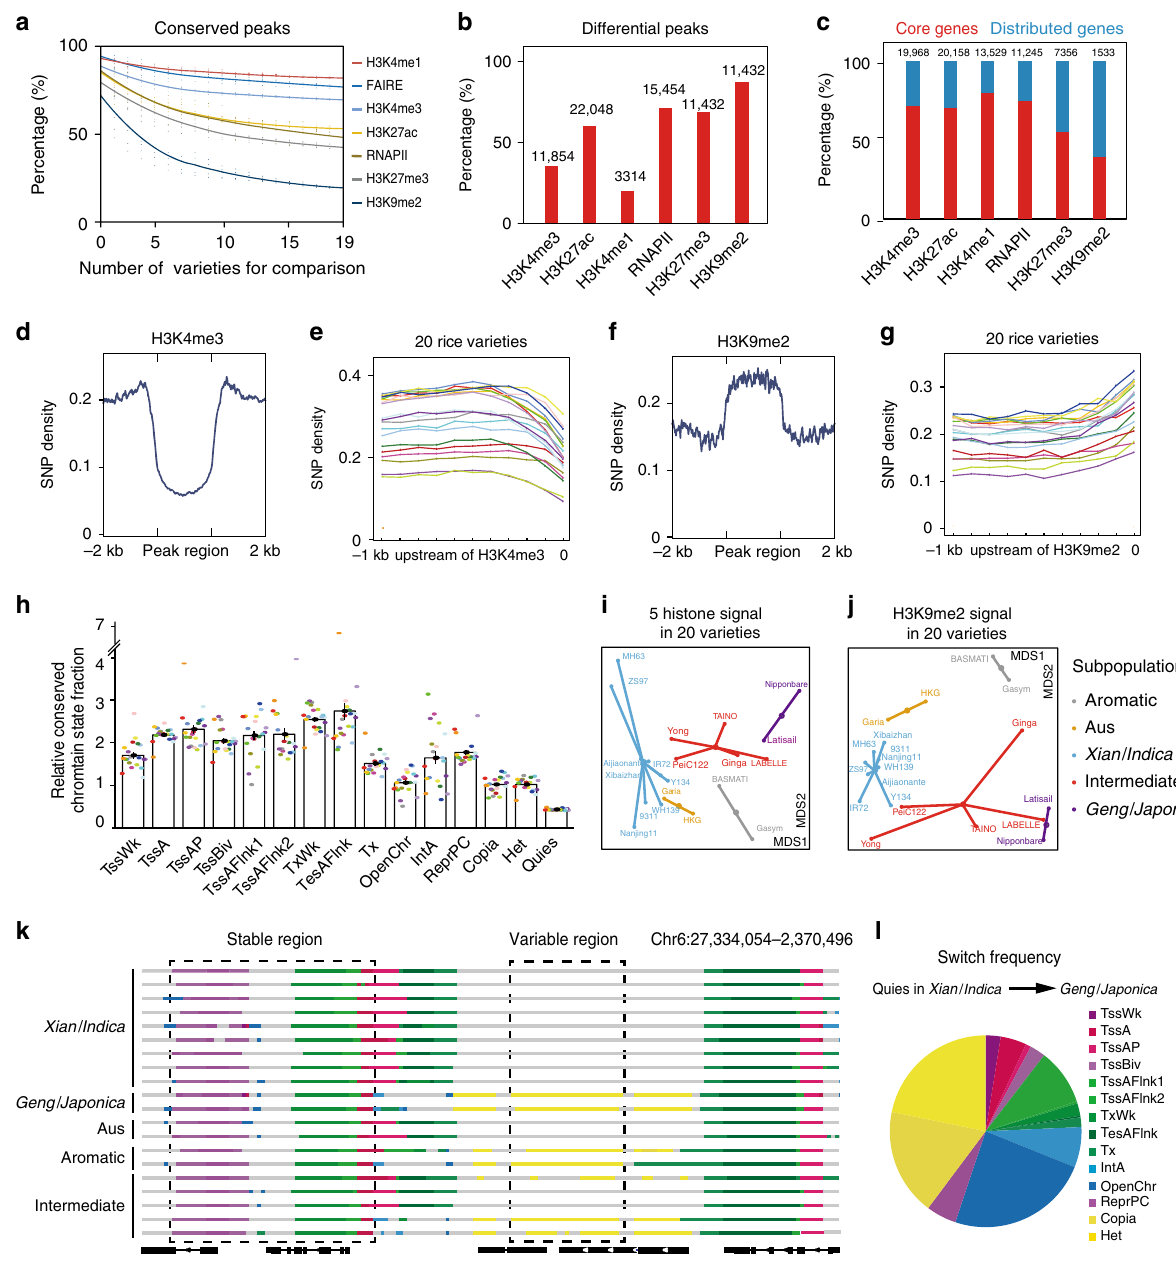
Fig. 6 Correlations of genetic variations and epigenome properties in 20 rice varieties. a Fraction of regions for each mark signal with signi fi cant differences based on pairwise comparison. Differential regions were identi fi ed using DESeq2 (using a q value cutoff of 10 − 2 and a fold-change between individuals >1.5). b Number and percentage of histone marks that were differential in 20 rice varieties. c Distribution of core and distributed genes marked by different histone modi fi cations in MH63. Core genes, present in more than 99% of 453 rice accessions; distributed genes, present in less than 99% of 453 rice accessions. The numbers in ( b ) and ( c ) indicate the sample sizes used in the analysis. d , f SNP (blue) density in H3K4me3 ( d ) and H3K9me2 ( f ) peak regions. e , g SNP enrichments upstream of H3K4me3-modi fi ed ( e ) and H3K9me2-modi fi ed ( g ) regions indicated by dotted boxes in 20 rice varieties. h The relative proportion of conserved chromatin state in the whole genome. i , j Nonmetric Multidimensional scaling (NMDS) plot of 20 rice varieties indicates their relationships based on similarity of fi ve histone modi fi cation signal ( i ) and H3K9me2 signal ( j ). First two dimensions are shown as MDS1 versus MDS2. The fi ve different subpopulations 52 Xian / Indica , Aus, Geng / Japonica , aromatic and an intermediate group, are shown in different colors. k An example of a nonvariable and a variable region for chromatin state in 20 varieties. All epigenome datasets were mapped to the Nipponbare reference sequence MSU7.0 53 . State colors are as in ( g ). l The pie chart of the relative frequency of CS from Xian / Indica to Geng / Japonica . Source Data underlying Fig. 6a, h – j, l are provided as a Source Data fi